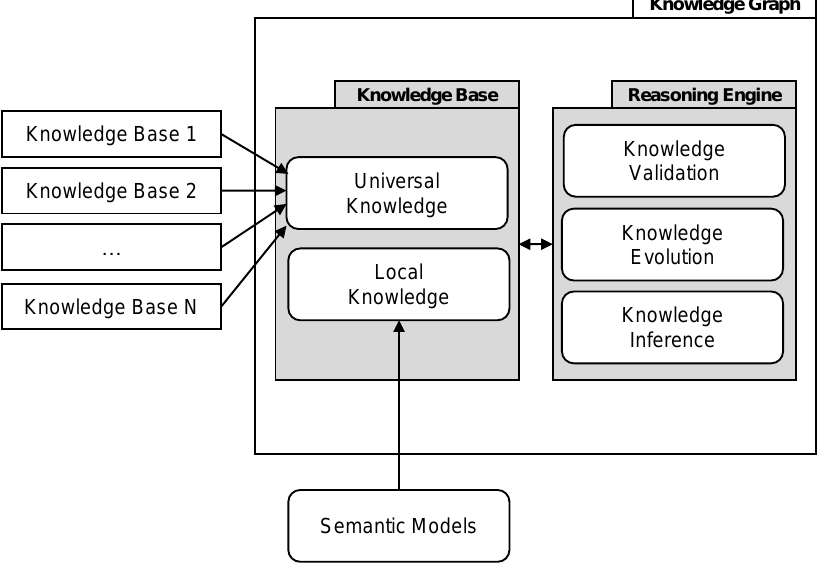
Figure 8. The components that we identify for our knowledge graph. We extend the proposal of Ehrlinger and Wöß [17] with more details and additional